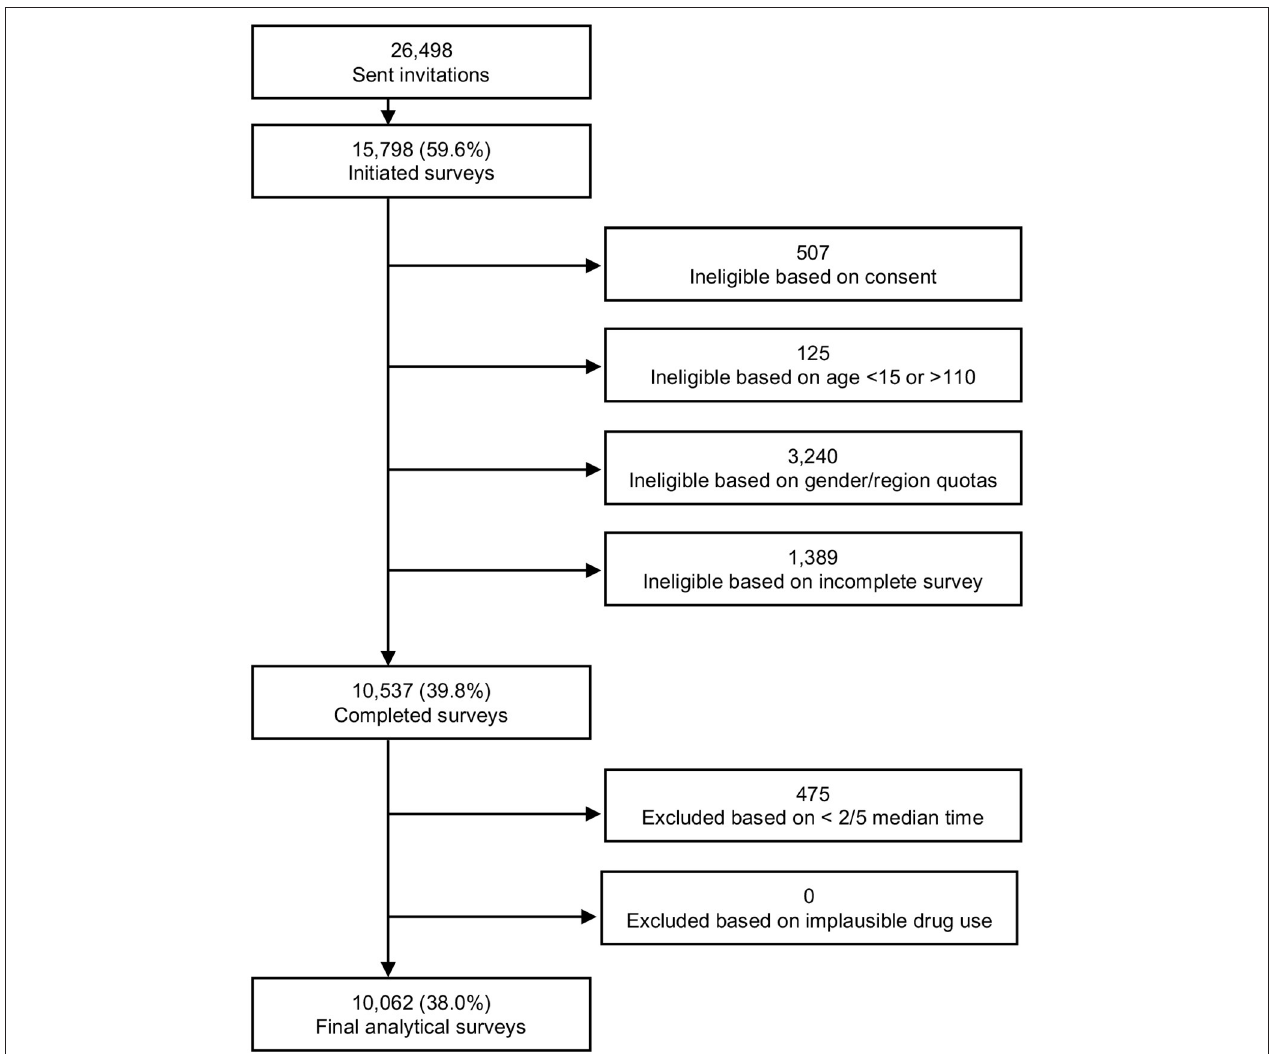
FIGURE 1 | Final analytic sample